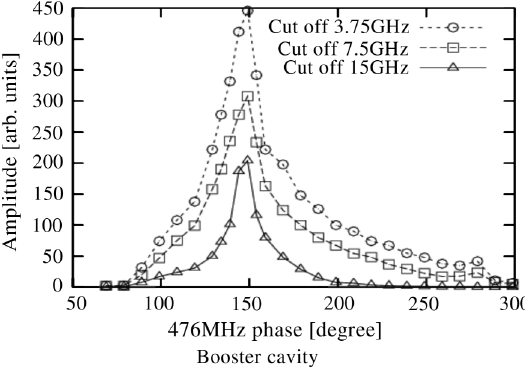
FIG. 19. Output voltage signals of the individual cutoff wave- guides dependent on the rf phase of the 476 MHz booster cavity at the SCSS test accelerator. The region below 150 degrees corresponds to an under bunching part and over 150 degrees corresponds to an over bunching part; 150 degrees is the rf crest- acceleration point. FIG. 21. Configuration of a typical CSR detection